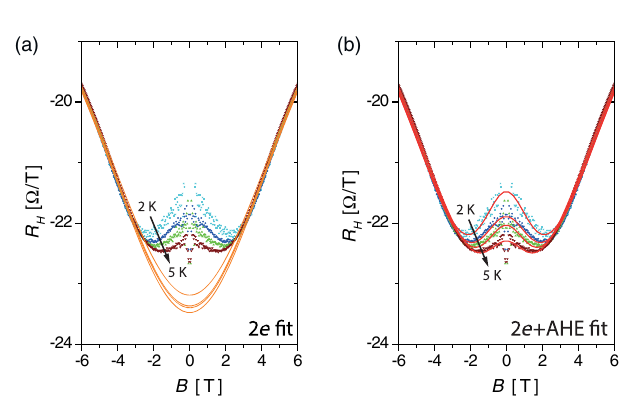
FIG. 4. (a) R H at low fields ( (cid:3) 6 T) for the sample grown at 1 × 10 − 4 mbar. Different colors of data points correspond p dep ¼ to temperatures of 2, 3, 4, and 5 K. The fits according to the 2 e model (solid lines) show a clear deviation from the experiment around zero field. (b) Same data as displayed in (a) now including fits according to the 2 e model with an additional AHE term (red solid